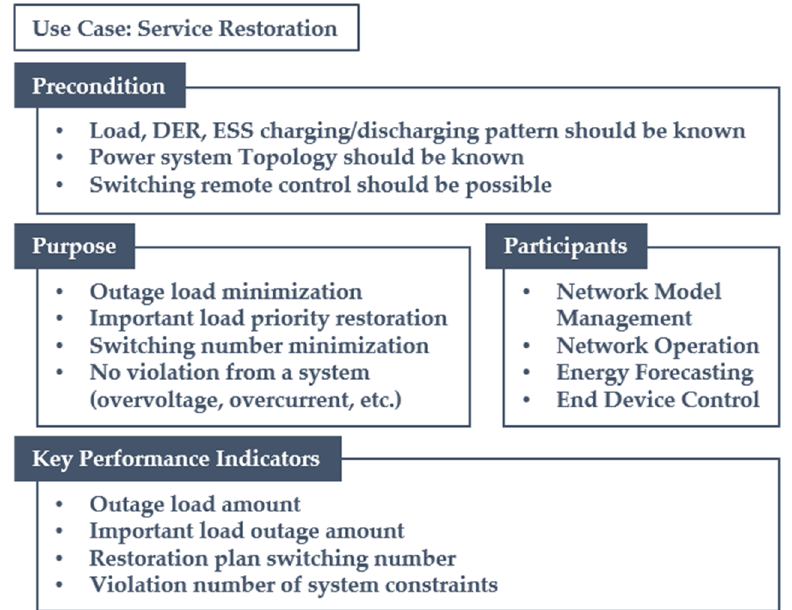
Figure 6. Diagram of the use case for establishing service restoration plans.